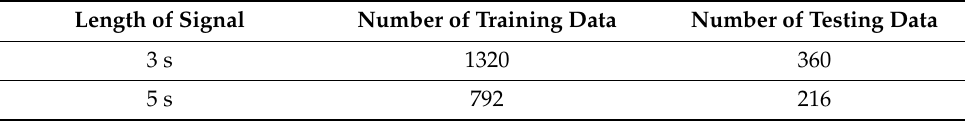
Table 2. Number of training and testing data by type of length of signal.